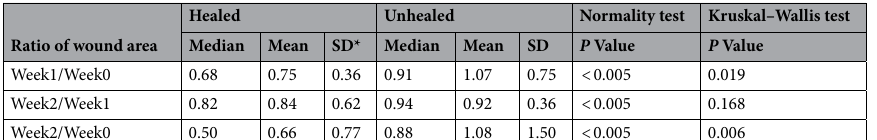
Healed Unhealed Ratio of wound area